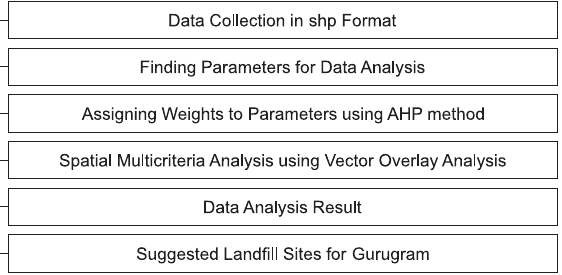
Fig. 2. Flowchart of